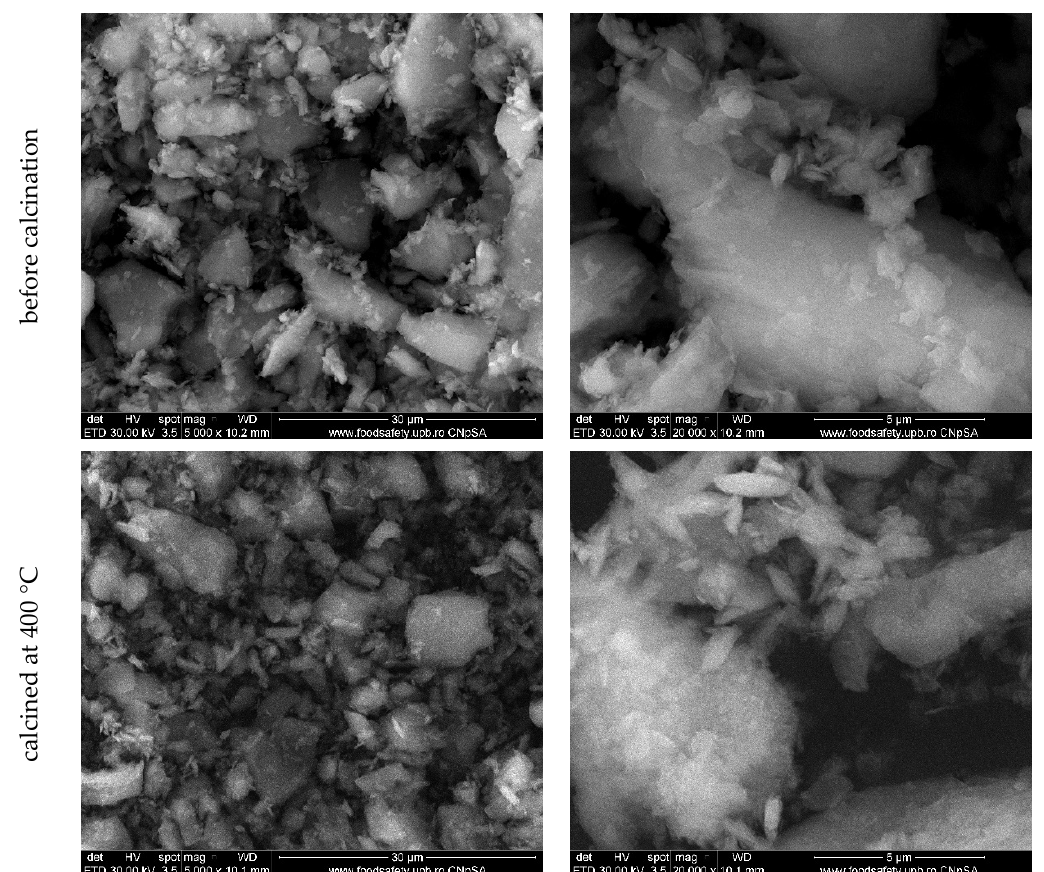
Figure 4. SEM images of the GDAH-03 powder before the thermal treatment and after calcination at 400 °C.